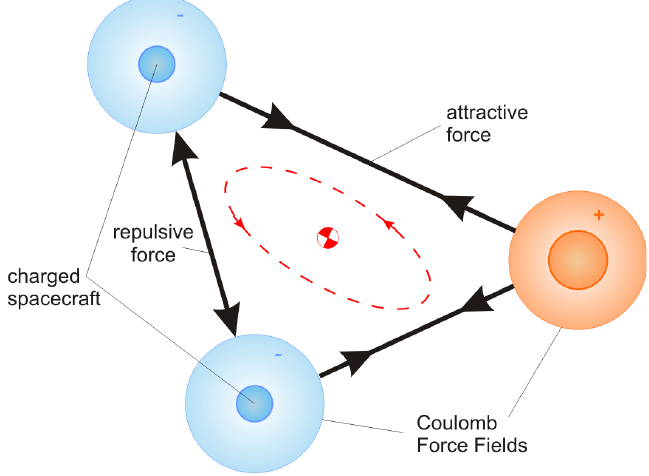
Figure 1. Illustration of a group of three Coulomb spacecraft orbiting in deep space around the center of mass of their